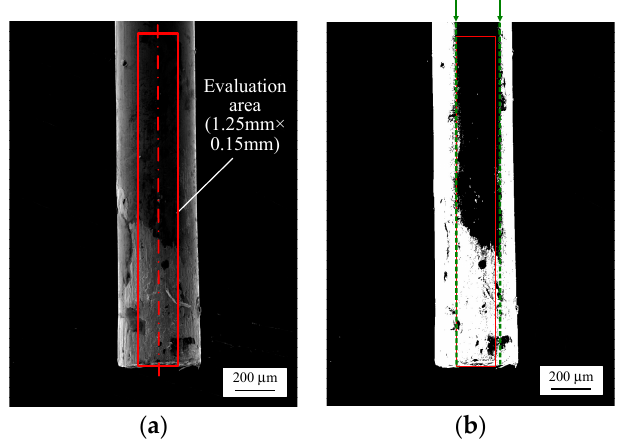
Figure 3. Evaluation of bonded area on the surface: ( a ) Evaluation area; ( b ) Binarization for boundary determination.